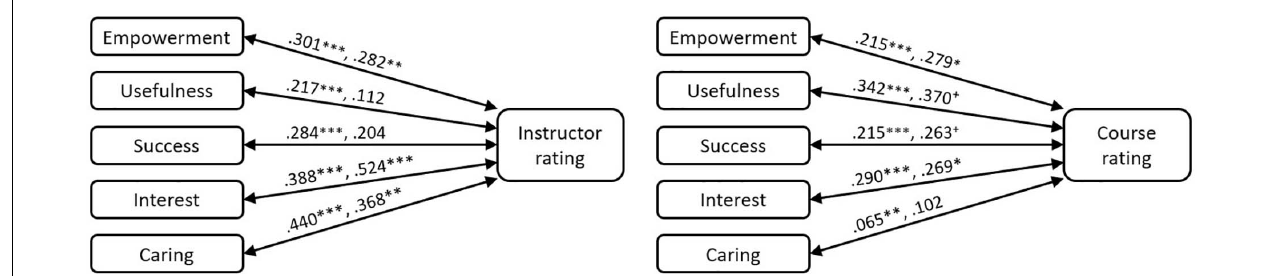
FIGURE 3 | Relationships between students’ MUSIC perceptions and instructor and course rating. On each arrow, the first number represents the student-level effect and the second number represents the class-level effect. + p < 0.10, ∗ p < 0.05, ∗∗ p < 0.01, ∗∗∗ p < 0.001.